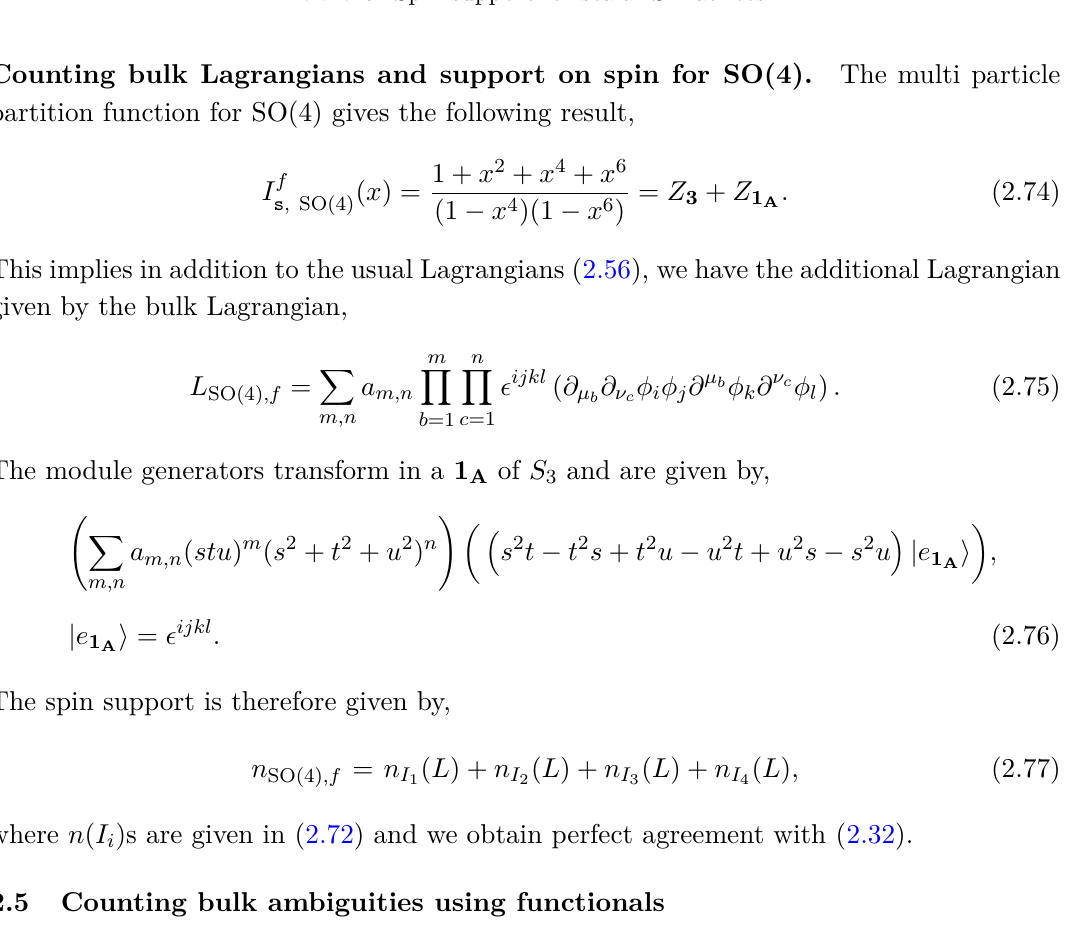
Table 6 . Spin support for scalar